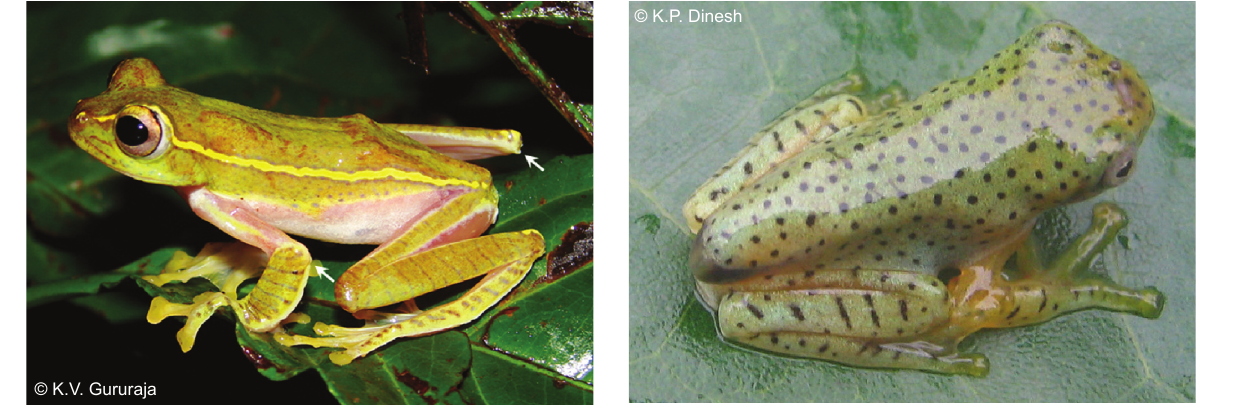
Image 2. Showing the prominent spurs on forelimb and hindlimb (indicated by arrows).